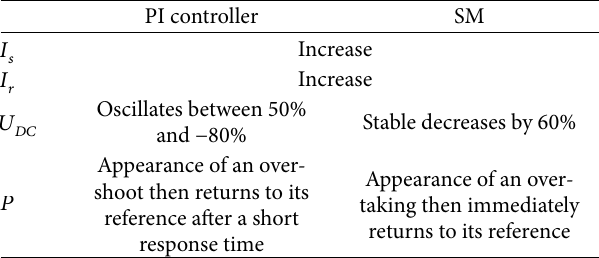
Table 4: Comparison results for 40% depth of stator voltage. Table 2: Filter and grid